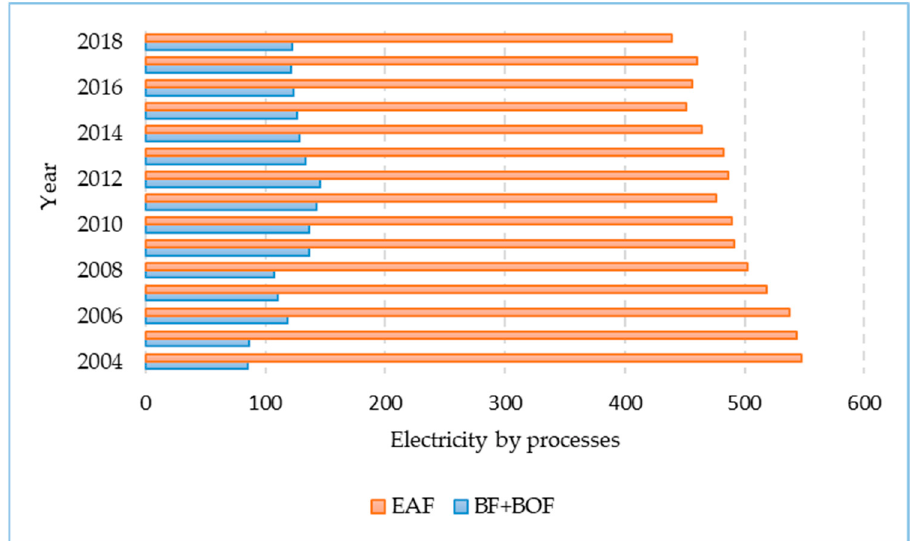
Figure 4. Electricity consumption by process in Polish steel industry from 2004 to 2018.